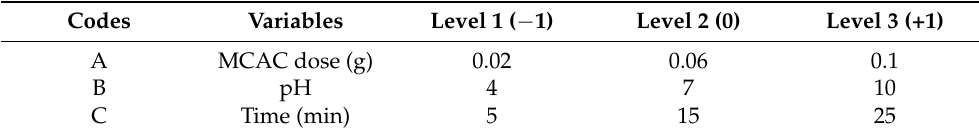
Table 1. Codes and actual variables and their levels in